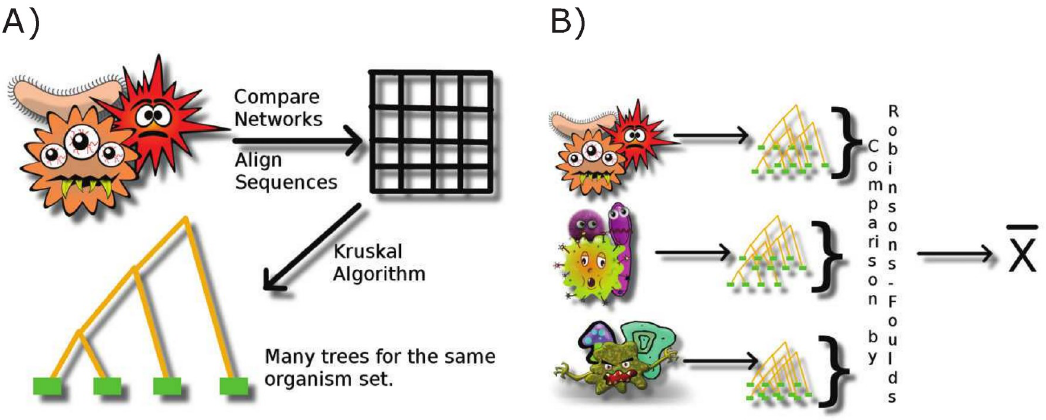
Fig 4. Workflow for evaluating and comparing dendrograms. A) We first obtain dendrogram for a given organism set. B) We compare the difference between dendrograms for many sets. Bacteria cartoons from https://pixabay.com/.